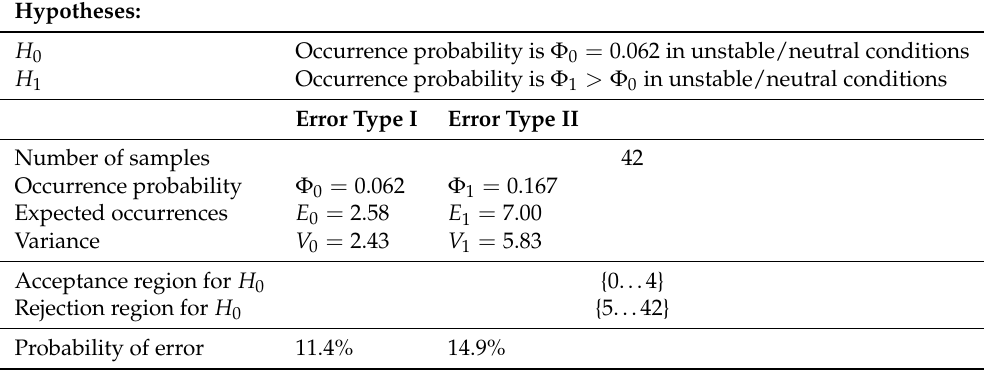
Table 5. Error estimation for the occurrence of non-Gaussian turbulence for the onshore unstable/neutral